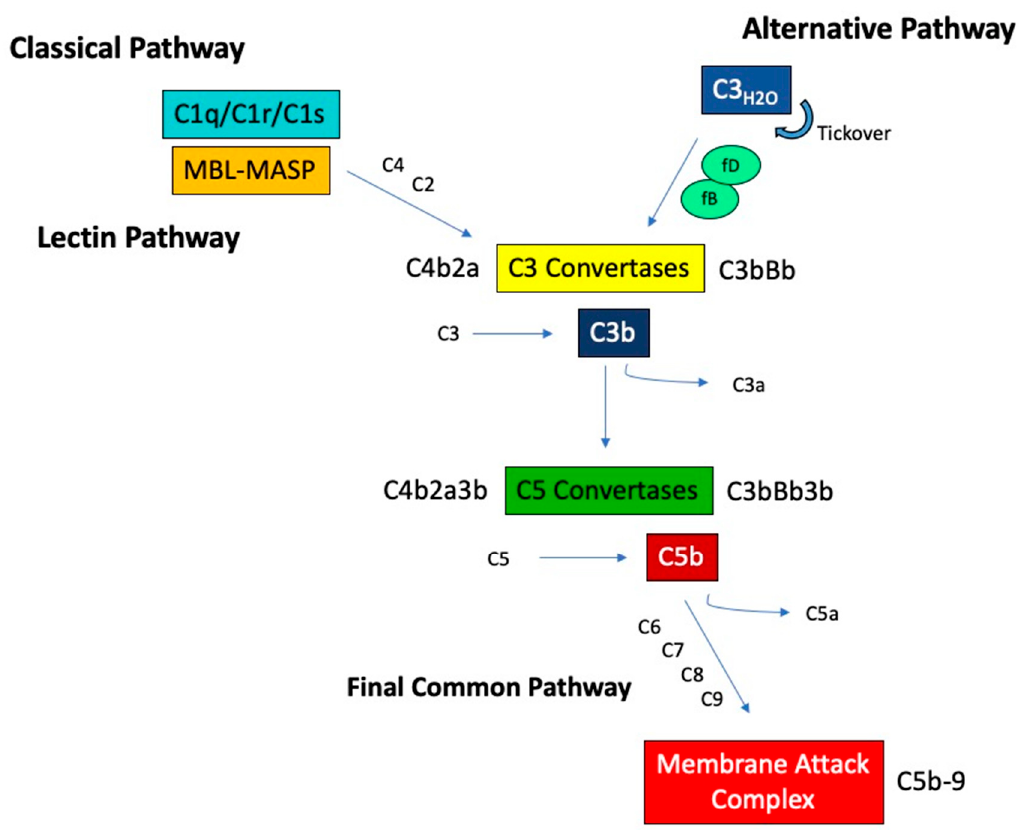
Figure 1. Overview of the complement activation pathways. MBL, mannose-binding lectin, MASP, MBL-associated serine protease.